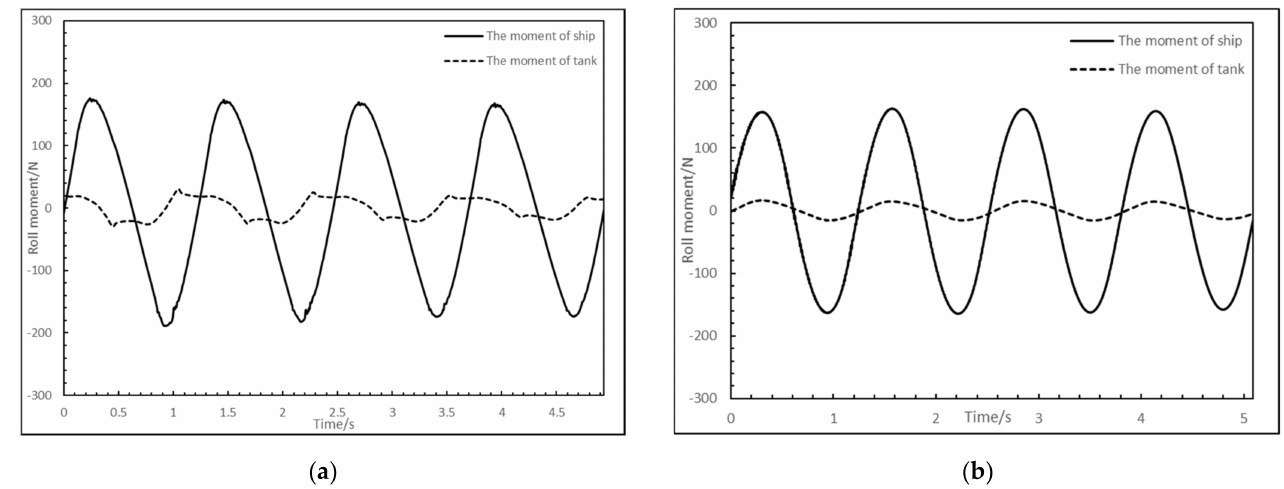
Figure 14. Roll moment of the ship and tank when the wavelength ratio is 0.787 ( a ) The height of liquid in the tank is 0.1 m; ( b ) The height of liquid in the tank is 0.2